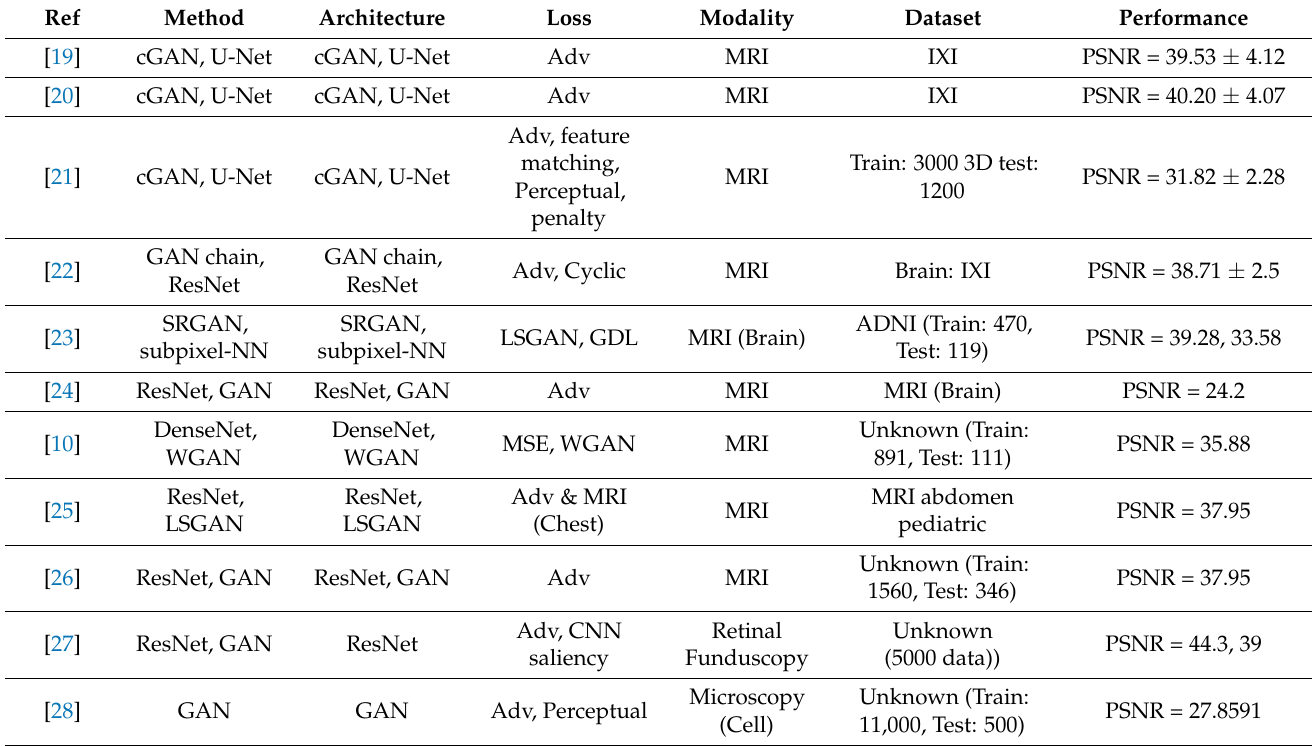
Table 1. Different techniques in biomedical images based on Generative Adversarial Networks (GANs).